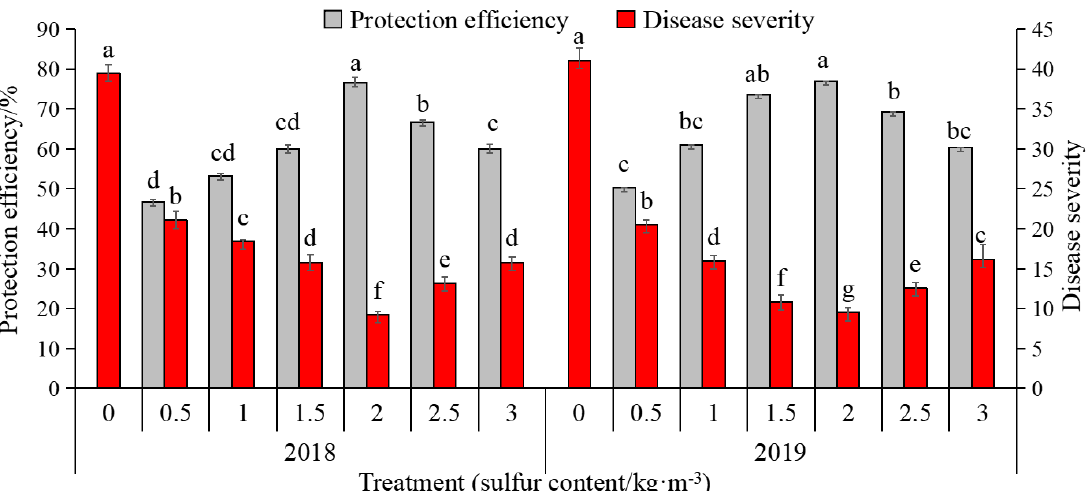
Figure 1. The effect of sulfur content on the disease index and protection efficiency of Psa_infected kiwifruit plants in fields. Vertical bars represented means ( n = 3) ± standard deviations (SD). Different lowercase letters indicate significant differences between different treatments ( p < 0.05). The same is shown